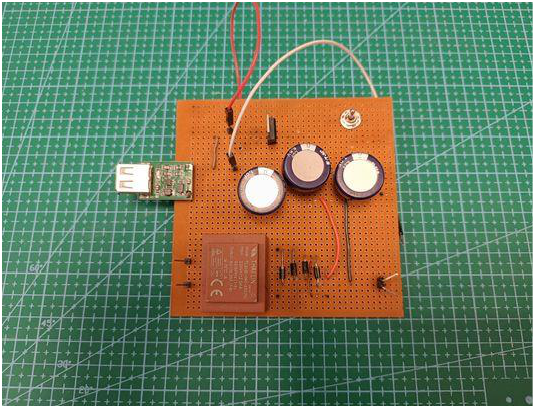
Figure 9. Power management, storage, and output circuits prototype.